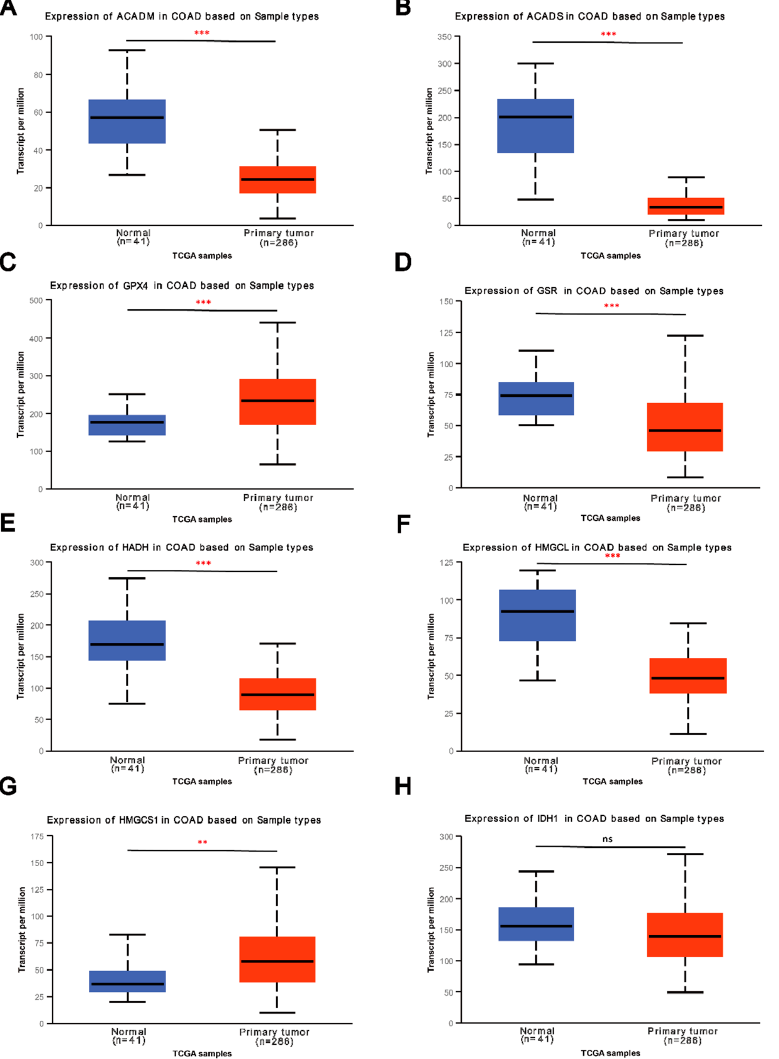
Figure 2. The expression of most of the key enzymes was downregulated in CRC. ( A – H ). The expression of these eight genes in colorectal cancer and normal colorectal tissues from UALCAN. (“ ns ” represents no significance, “ ** ” represents p < 0.01 , “ *** ” represents p<0.001 ). The expression of five genes (ACADM, ACADS, GSR, HADH and HMGCL) in CRC were extremely lower than those in paired normal colorectal tissues ( p <